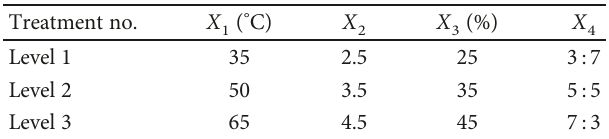
Table 2: Factors and levels of orthogonal